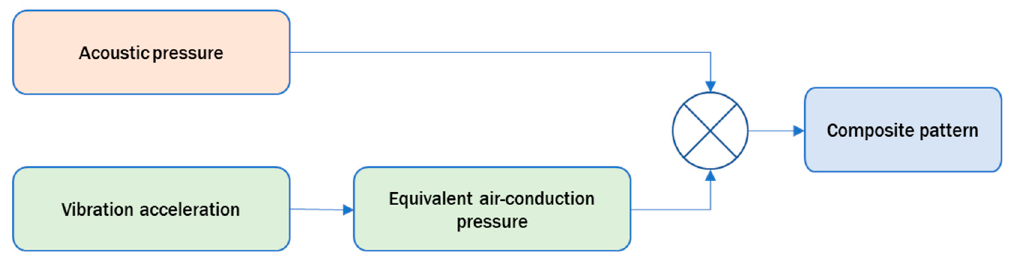
Figure 2. Procedure for the estimation of hearing stimulation pattern.